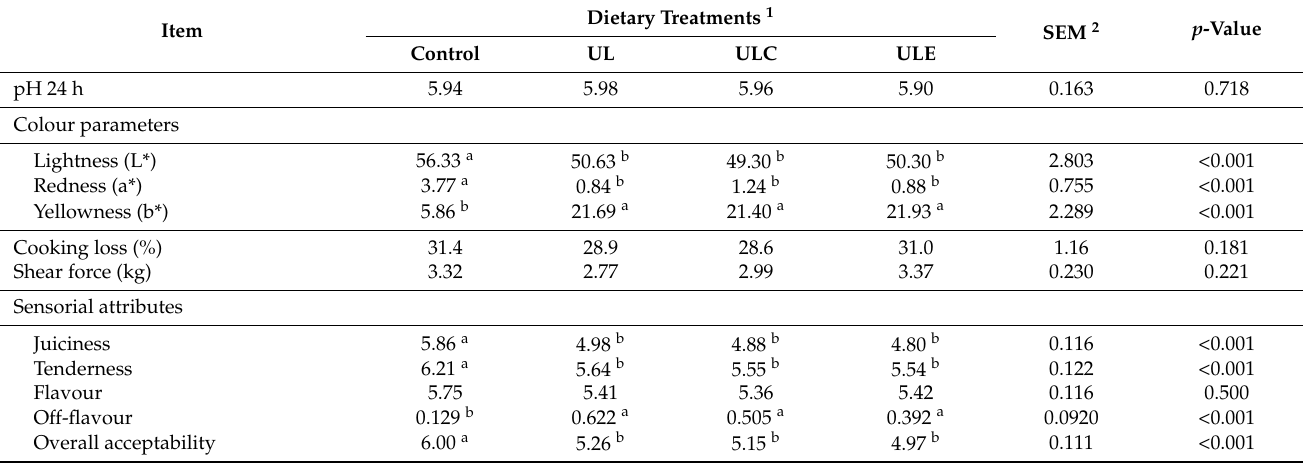
Table 4. Meat quality and carcass traits of broiler breast ( n =